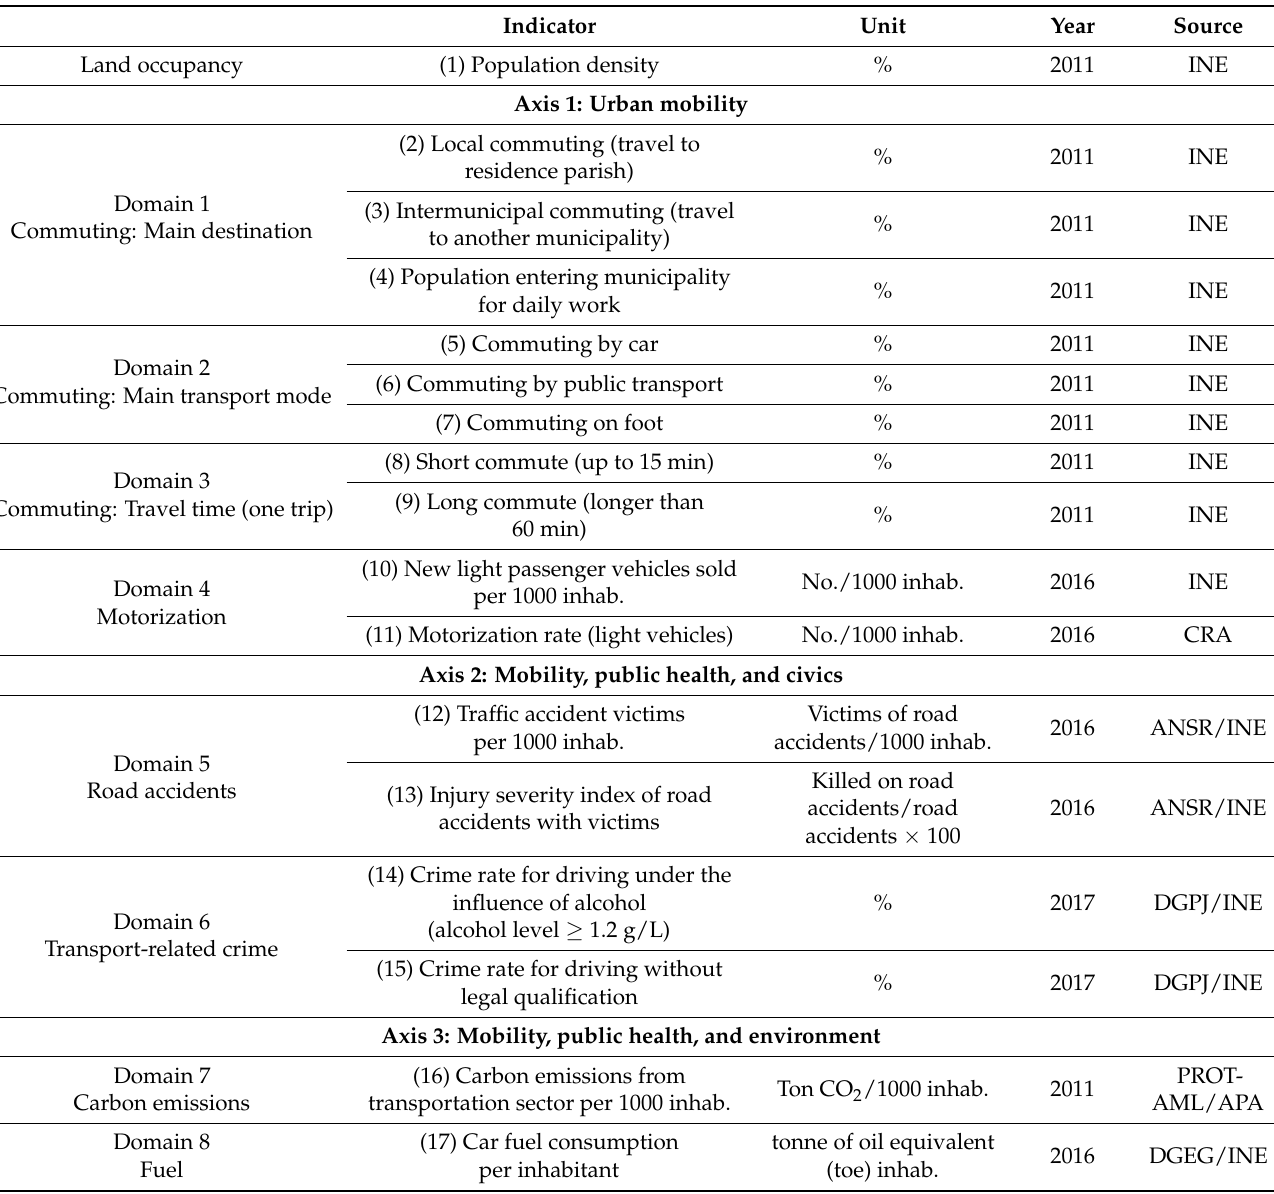
Table 2. Indicators from official entities and respective metadata. INE, National Institute of Statistics; CRA, Vehicle Registry Office; ANSR, National Road Safety Authority; DGPJ, Directorate-General for Justice Policy; PROT-AML, Regional Land Use Management Plan of the Lisbon Metropolitan Area; APA, Portuguese Agency for Environment; DGEG, Directorate-General for Energy and